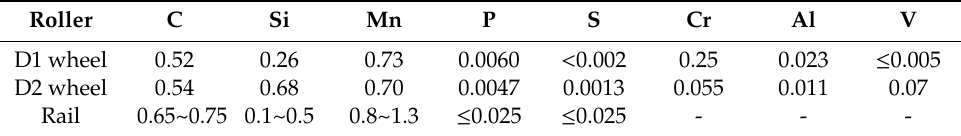
Table 1. Chemical composition of the wheel and rail rollers (wt%).